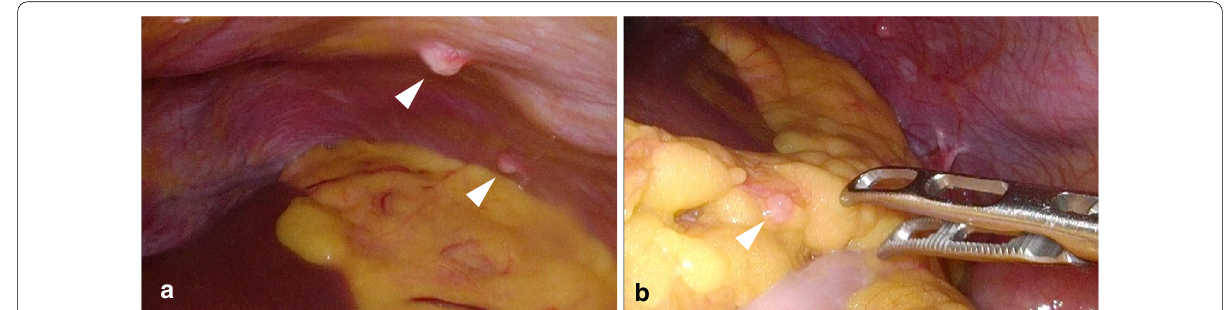
Fig. 2 Intra-abdominal nodules recognized during laparoscopic surgery in the a left upper abdomen and b greater omentum (arrowheads)